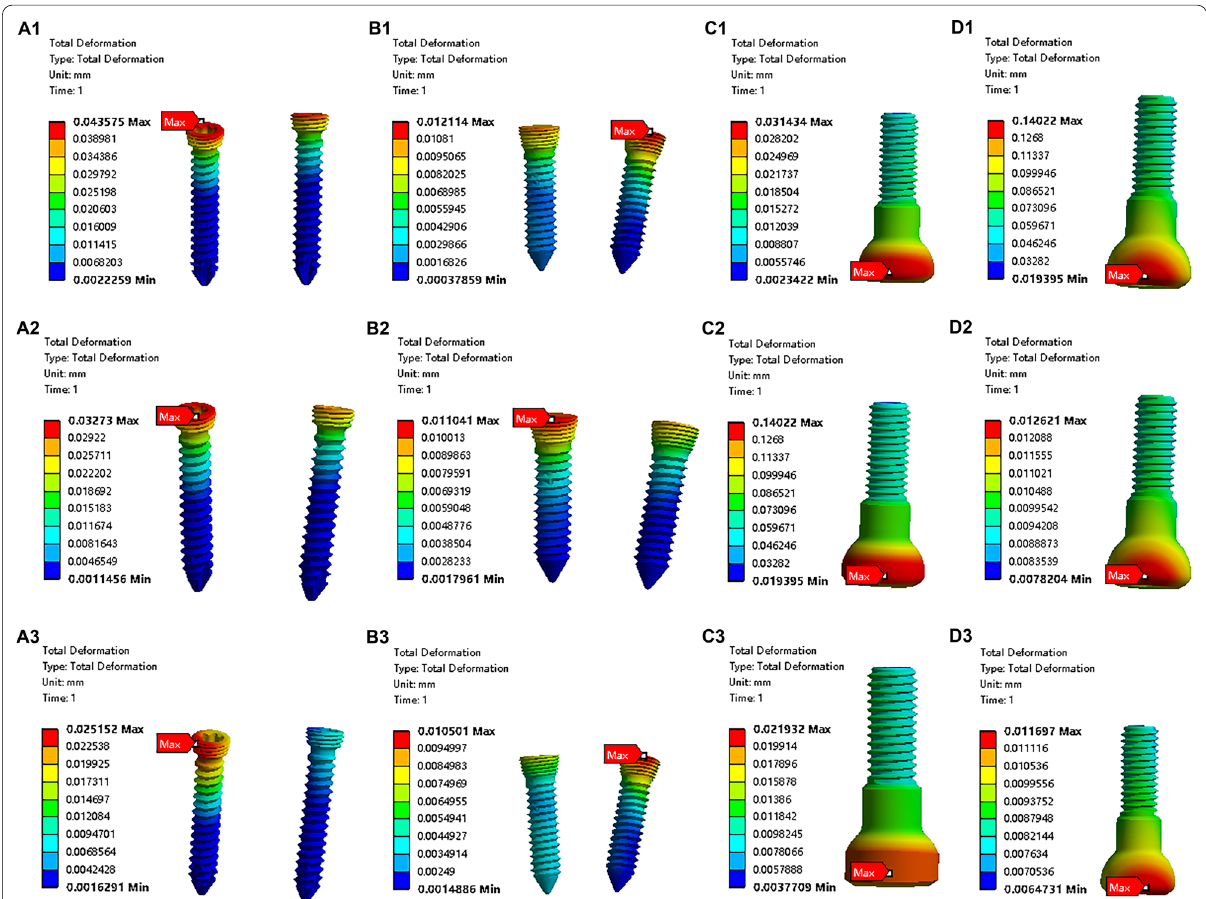
Fig. 5 The total deformation of the fixation bolt. A1 The total deformation of the fixation bolts when using a double 2.0‑mm bolt at 30° elbow flexion. A2 The total deformation of the fixation bolts when using a double 2.0‑mm bolt at 90° elbow flexion. A3 The total deformation of the fixation bolts when using a double 2.0‑mm bolt at 130° elbow flexion. B1 The total deformation of the fixation bolts when using a double 2.5‑mm bolt at 30° elbow flexion. B2 The total deformation of the fixation bolts when using a double 2.5‑mm bolt at 90° elbow flexion. B3 The total deformation of the fixation bolts when using a double 2.5‑mm bolt at 130° elbow flexion. C1 The total deformation of the fixation bolt when using a single 4.0‑mm bolt at 30° elbow flexion. C2 The total deformation of the fixation bolt when using a single 4.0‑mm bolt at 90° elbow flexion. C3 The total deformation of the fixation bolt when using a single 4.0‑mm bolt at 130° elbow flexion. D1 The total deformation of the fixation bolt when using a single 4.5‑mm bolt at 30° elbow flexion. D2 The total deformation of the fixation bolt when using a single 4.5‑mm bolt at 90° elbow flexion. D3 The total deformation of the fixation bolt when using a single 4.5‑mm bolt at 130° elbow